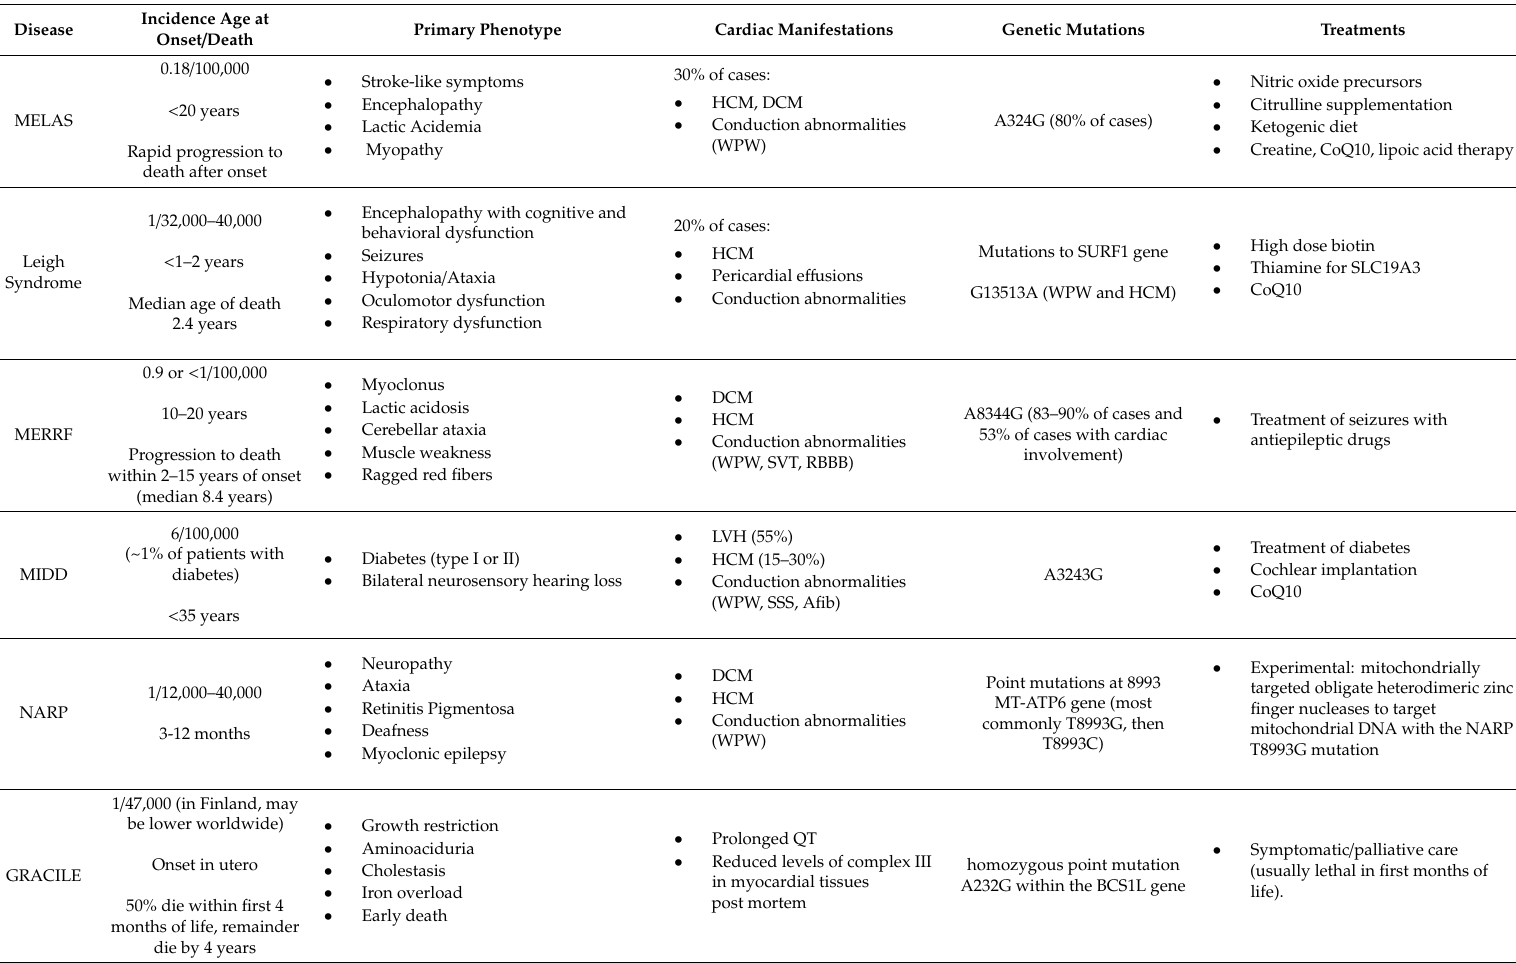
Table 1. Summary of mitochondrial disorders with cardiac